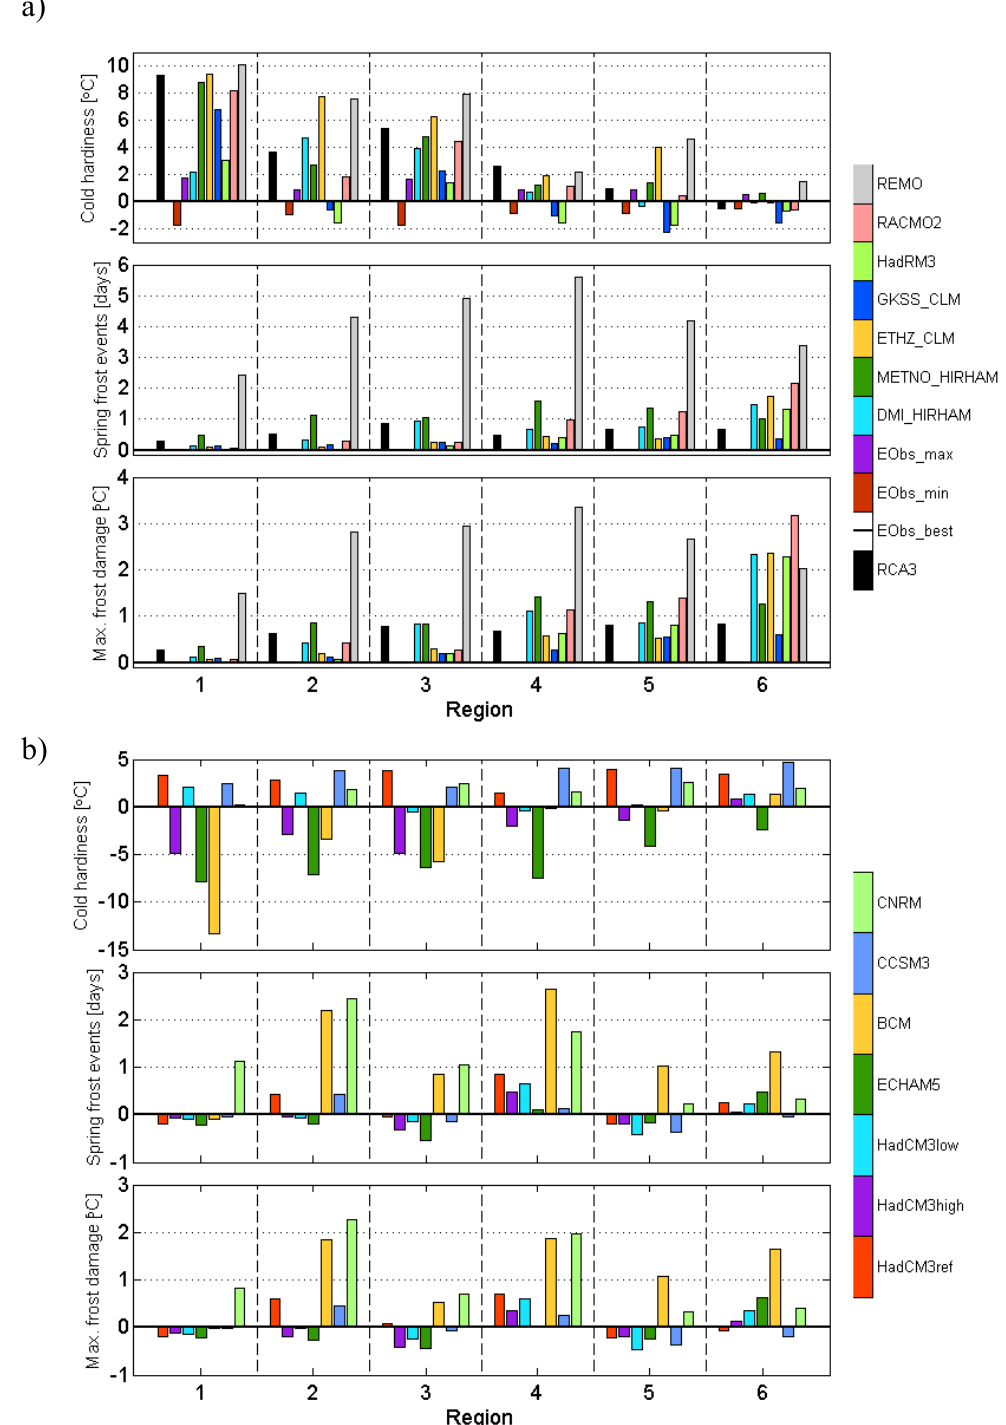
Figure 7. Deviations from a reference value of the two CHM model comparisons: a) spread among the RCM_ERA ensemble members (i.e. RCM_ERA minus E-Obs), b) spread among the RCA3_GCM ensemble members during the control period (i.e. RCM_GCM 1961-90 minus RCA3_ERA 1961-90). The three panels of a) - b) show the different CHM model variables (cf. Table 1), from top to bottom: number of cold hardiness level, spring frost events and maximum frost damage level.